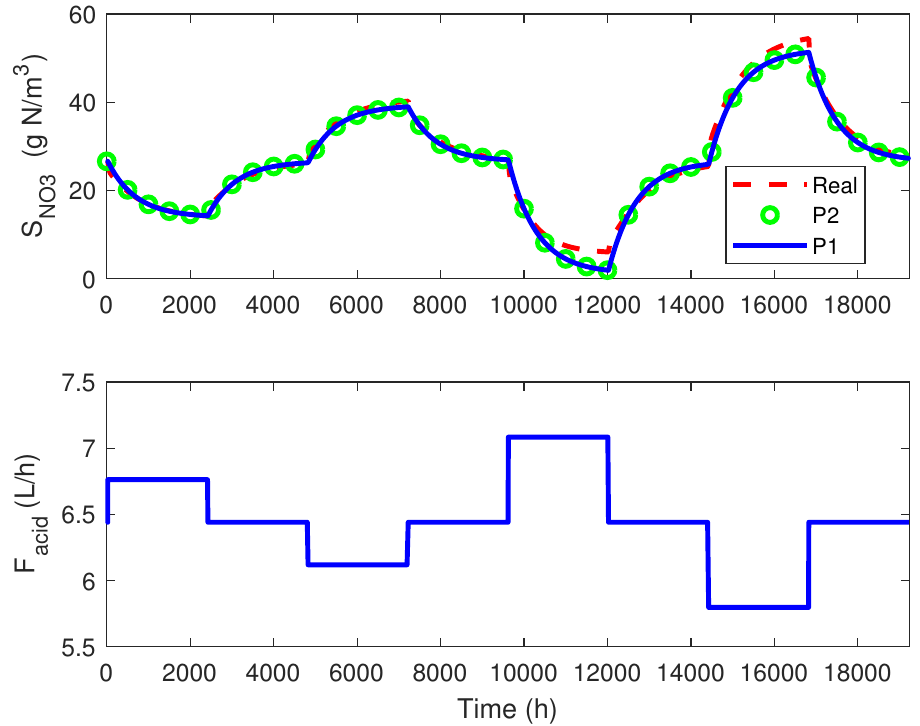
Figure 3. S NO 3 response following several step variations in acid flowrate.